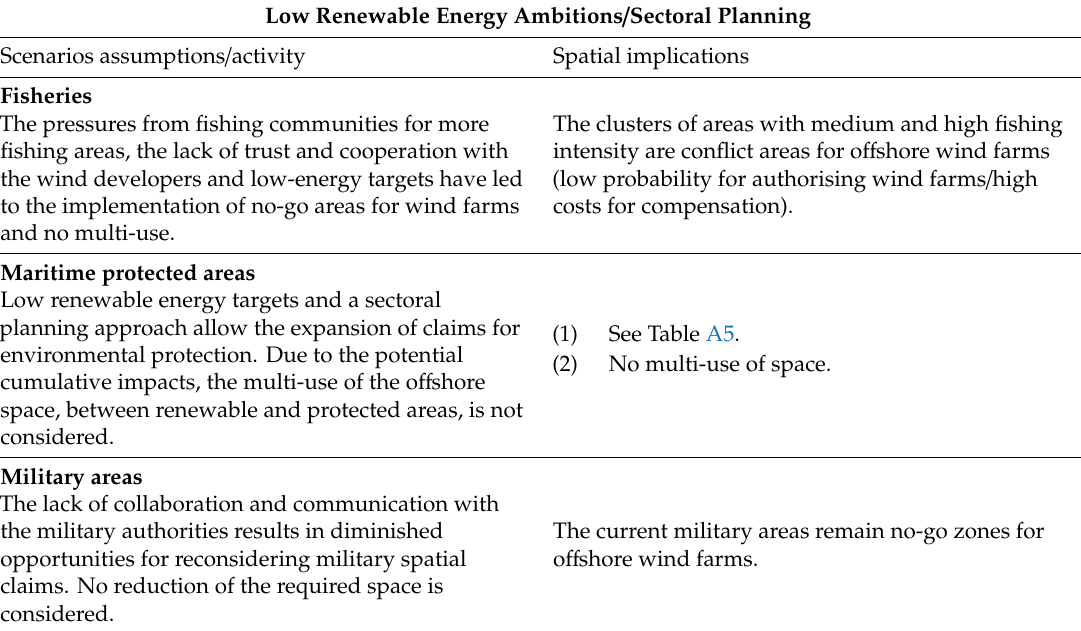
According to our calculations (Figure A2), the increase in the tra ffi c density will not imply wider shipping lanes for the existing designated areas (IMO routes, national routes).